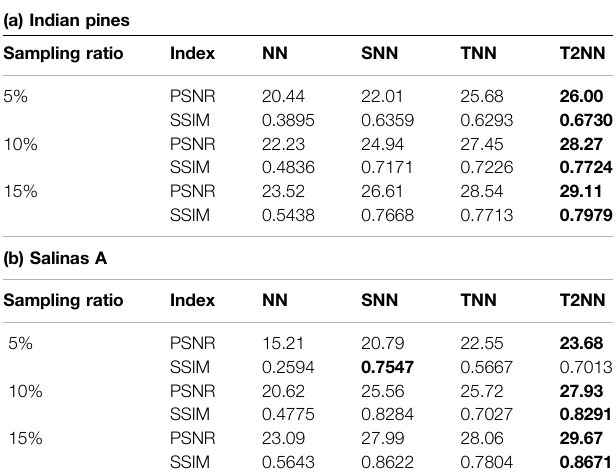
TABLE 2 | PSNR and SSIM values obtained by four norms (NN [30], SNN [22], TNN [25], and our T2NN) for noisy tensor completion on the hyperspectral datasets.